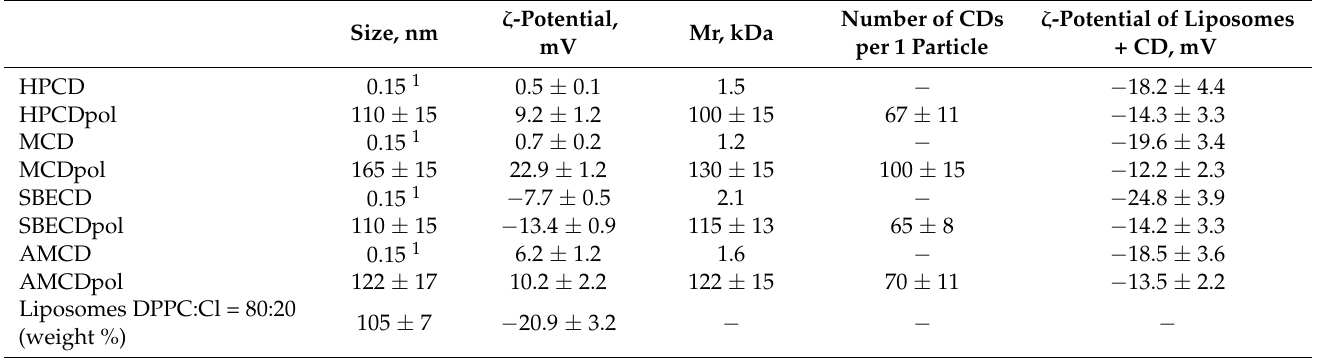
Table 1. The size and ζ -potential of CD, CDpol and their complexes with liposomes, pH 7.4 (0.02 M Na-phosphate buffer solution), 22 ◦